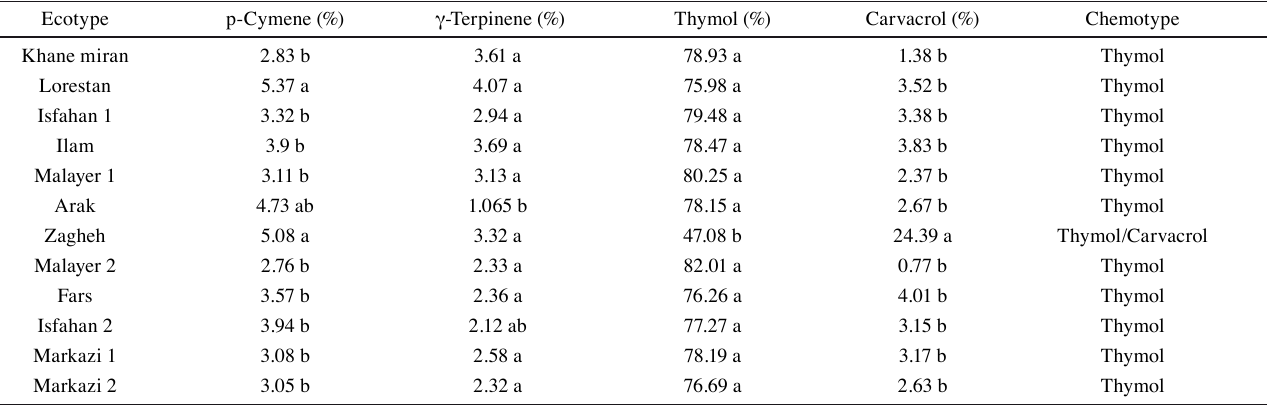
Tab. 5: Major constituents in essential oil of different ecotypes of T. daenensis Ecotype